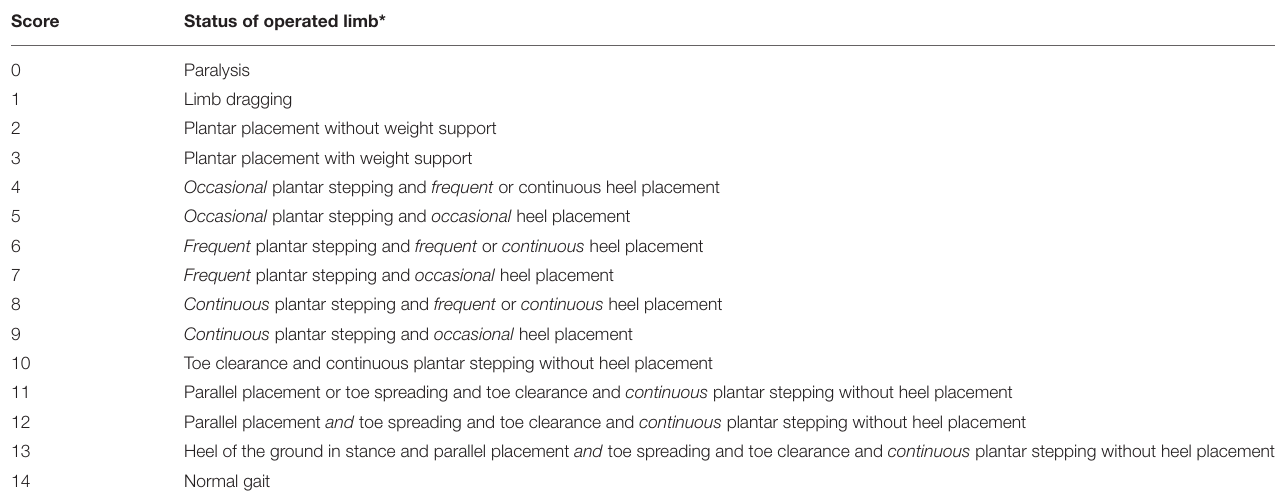
TABLE 1 | Scales for open field locomotor performance.